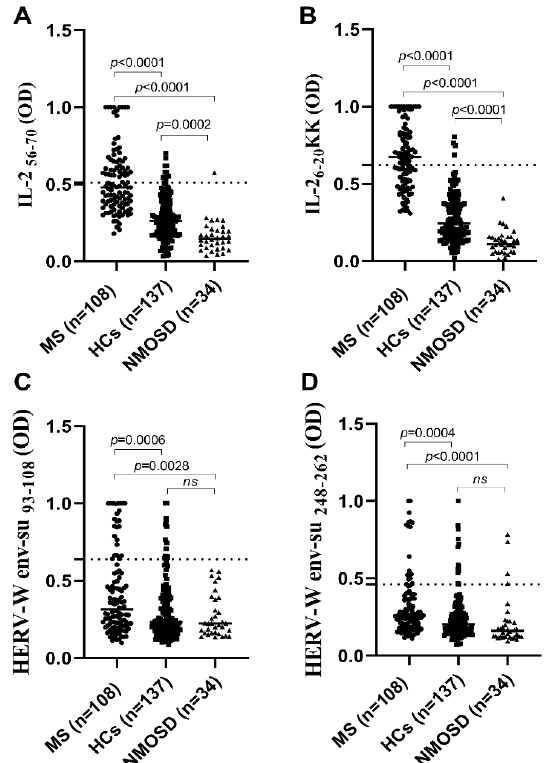
Figure 1. ( A–D ) Abs reactivity of MS, NMOSD, and healthy subjects against peptides derived from interleukin 2 (IL-2) ( A , B ) and human endogenous retrovirus type W (HERV-W) ( C , D ). Values relative to statistical differences between groups are reported above each distribution. Dotted lines correspond to the positivity threshold established for each peptide based on the receiver operating characteristic (ROC) curve analysis.